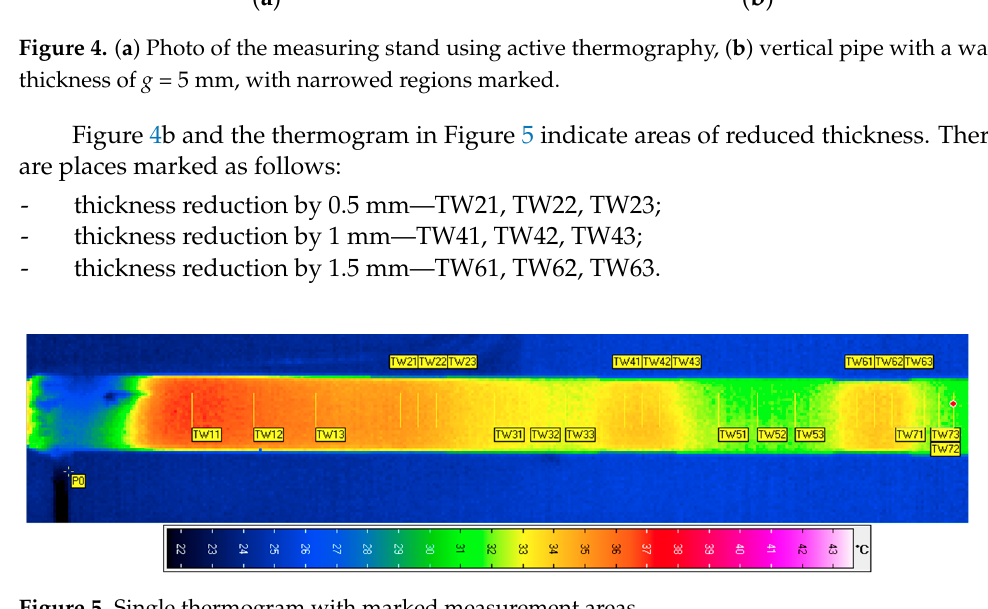
( b ) Figure 6. ( a ) Boiler screen thermogram using a telephoto lens 6 × 8, and ( b ) using a standard lens 50 × 68. The configuration of the measuring station allowed us to obtain parameters that con- firmed the effectiveness of the proposed method. Based on the registered thermogram sequences, using Irbis, and the VarioCAM dedicated software, timelines of temperature changes were generated for all linear markers, as shown in Figure 5. The results of pro- cessing data from thermograms were saved in text files. Figure 7 shows the successive experimental stages. After building the stand and cal- ibration, which consisted of temperature sensors and the object’s emissivity, the wall thicknesses of pipes were checked in places of standard thickness, and in places where the